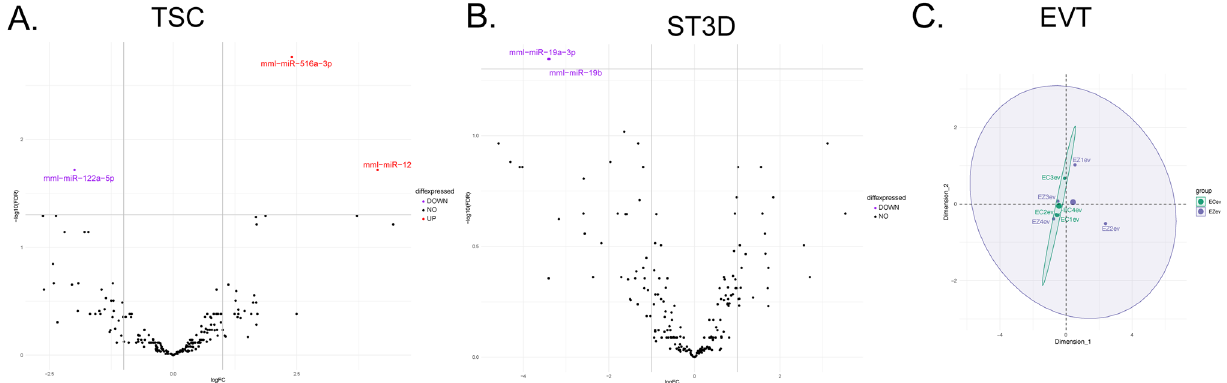
Figure 7. ZIKV exposure impact on EV miRNA cargo. Volcano plots of miRNAs detected in ( A ) TSC, and ( B ) ST3D EVs. miRNAs significantly differentially expressed are highlighted on the plots (Purple indicates decreased with ZIKV exposure; Red indicates increased with ZIKV exposure; Black indicates not significantly different). ( C ) An MDS plot of the EVT miRNA profile of Control (Green) and ZIKV exposed (Purple)